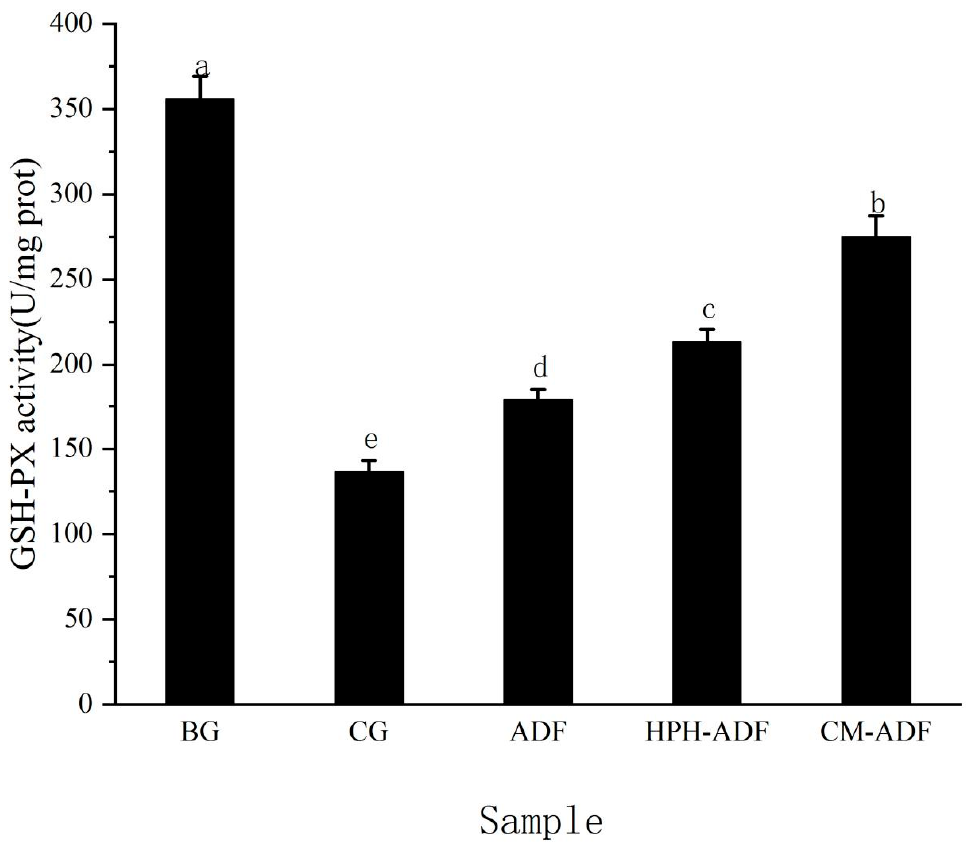
Figure 4. Effect of ADF on GSH-PX activity in rat liver. Data are reported as mean ± standard deviation from seven rats in each group, except for the blank group (five rats). Values with different letters are significantly different ( p < 0.05).